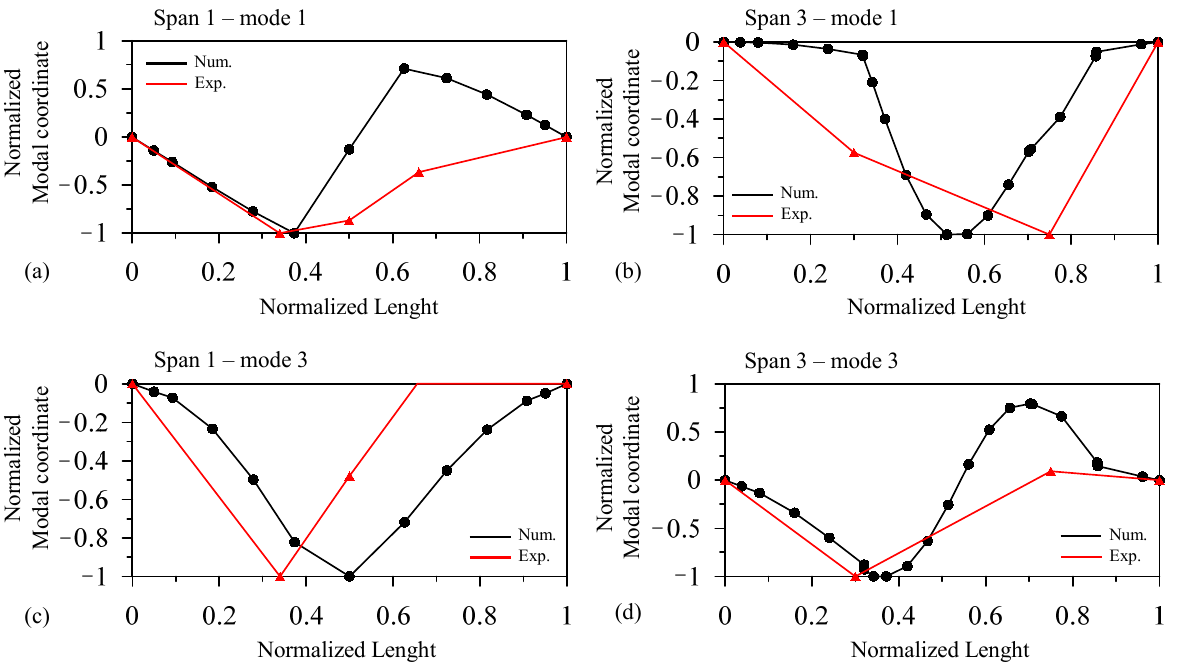
Figure 17. Comparison between experimental and numerical modal shapes: ( a , b ) mode 1 and ( c , d ) mode 3 in corresponding spans 3 and 4.